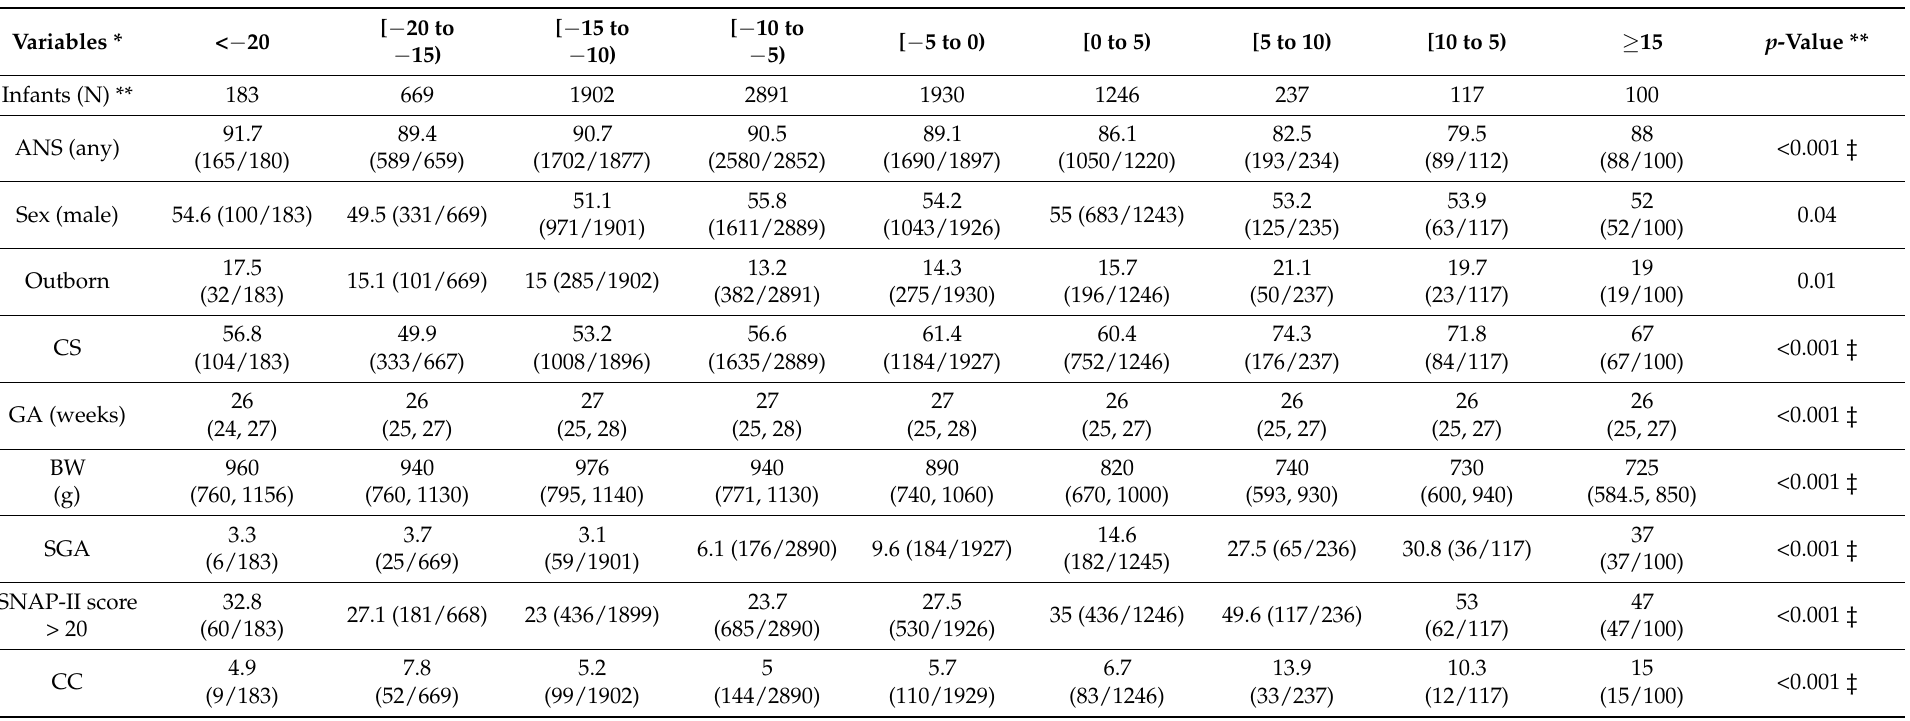
Table 1. Comparison of maternal and neonatal characteristics among the groups of weight change (% of birth weight) between birth and day